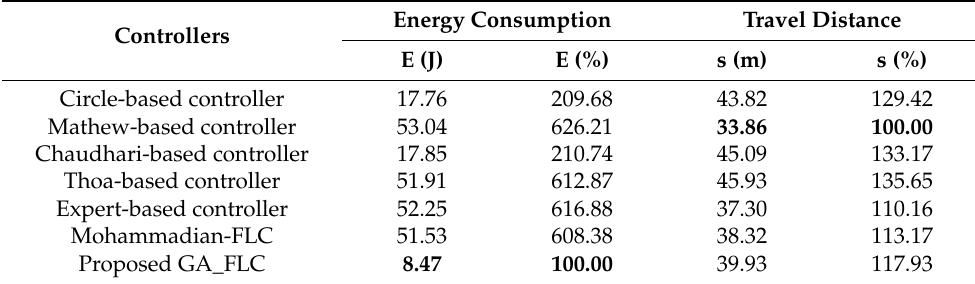
Table 13. Energy consumption and travel distance of the robot when the robot tracks the sharp turn path by the different controllers. Bold values are the best in the appropriate